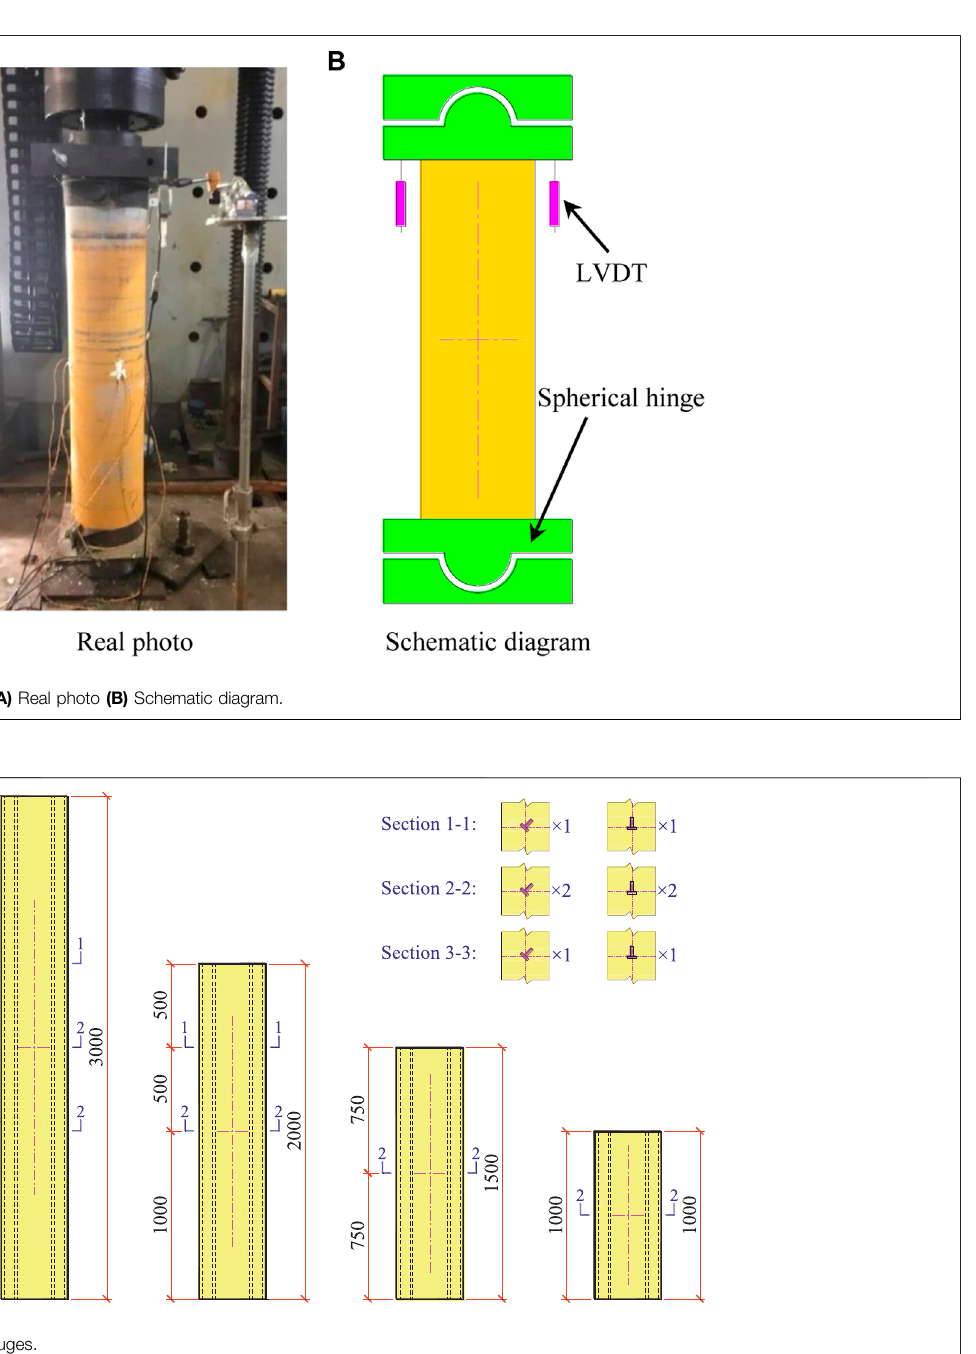
FIGURE 3 | Arrangement of strain